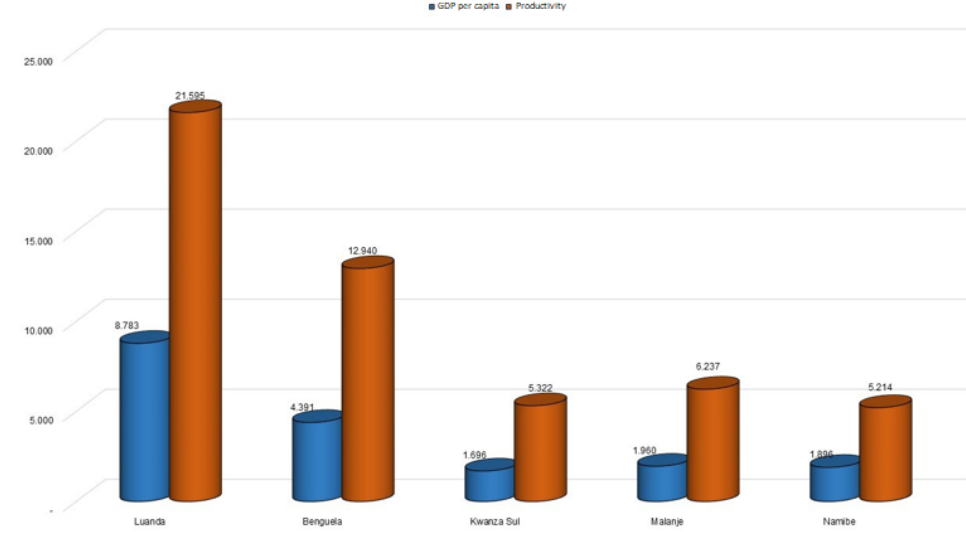
Figure 10. Difference in productivity between provinces in Angola. Source: Adapted from the Report on Inequalities and Asymmetries in Angola.